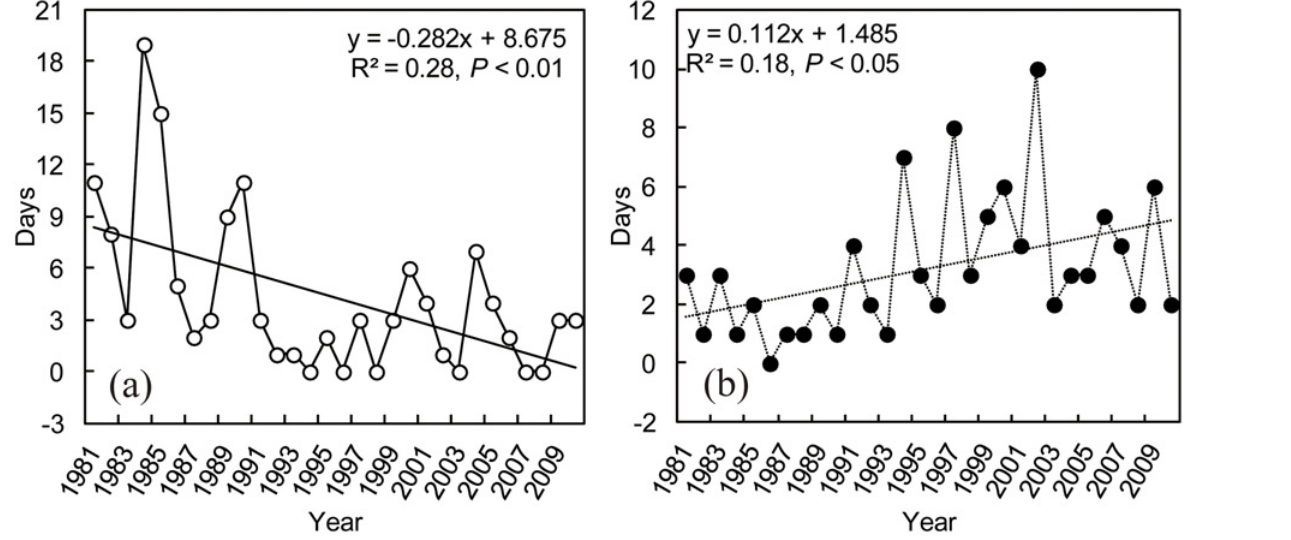
Fig 3. Yearly variations in days for extreme heating (a) and cooling (b) energy consumption of large venue